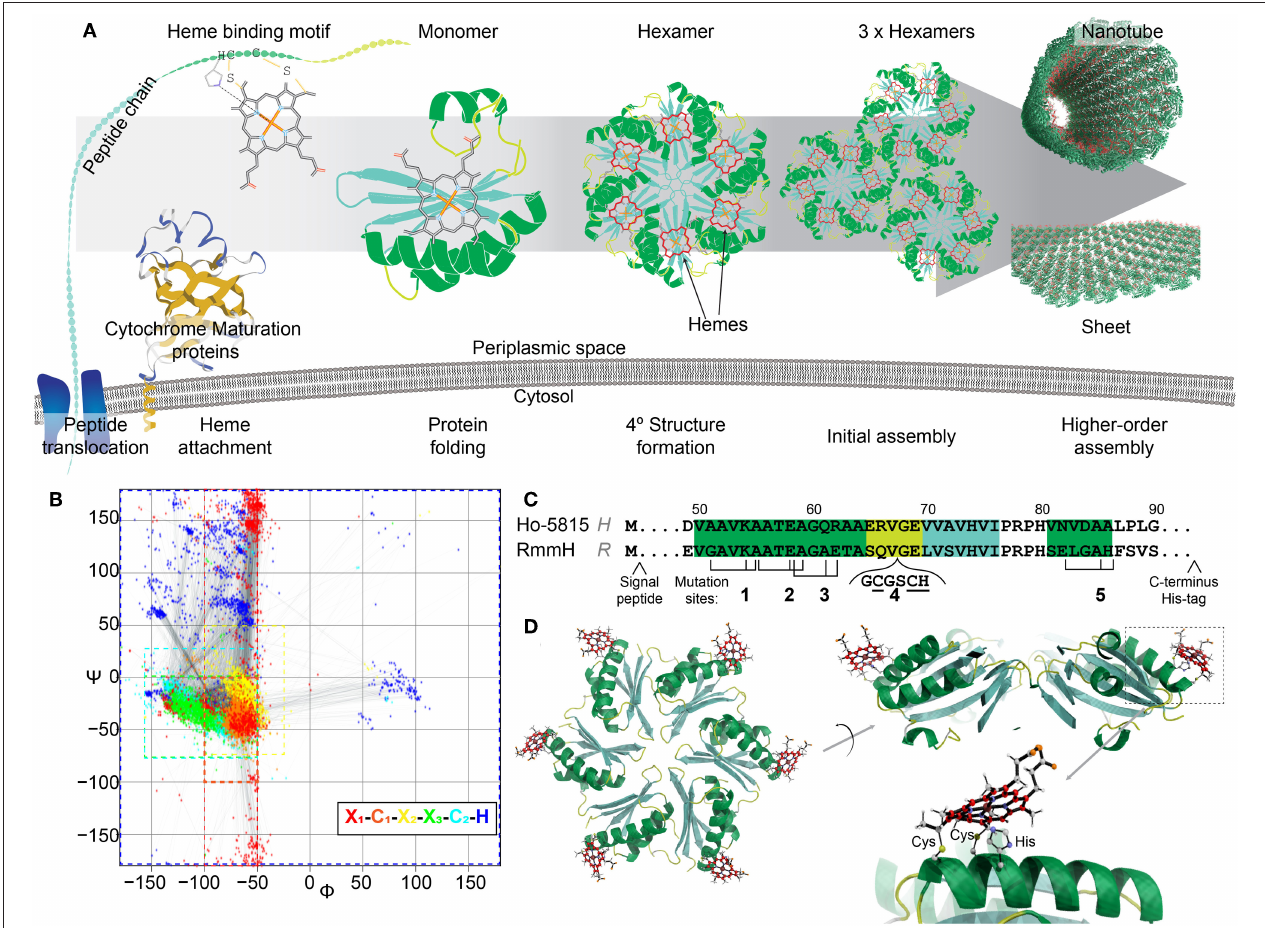
FIGURE 1 | Design of heme-functionalized BMC-H shell proteins. (A) Cartoon schematic showing a hypothetical pathway of a heme from attachment on a shell protein to the formation of large structures. (B) Ramachandran plot of torsion angles within the heme binding motifs of naturally occurring cytochrome c structures ( n = 249 heme binding motifs). Each color represents one amino acid in the motif. (C) Partial protein sequences of Ho-5815 and RmmH shell proteins. Secondary structures are highlighted (green: helix, yellow: loop, cyan: sheet). Three amino acid residues (black ticks) at Mutation sites 1,2,3, and 5 were changed to generate a heme binding motif (CxxCH). Six amino acids were inserted at mutation site 4 to introduce the heme binding motif at the loop region. (D) Molecular dynamics model of BMC-H variant